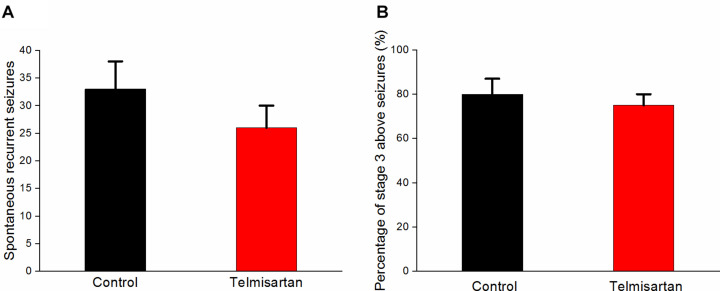
Spontaneous recurrent seizures (SRS) in both the control and telmisartan groups following status epilepticus and epileptogenesis. (A) Both groups showed similar numbers of SRS (p = 0.2) although slightly fewer seizures occurred in the Telmisartan group. (B) The percentage of rats with stage 3 and above seizures was similar in both groups (p > 0.1).